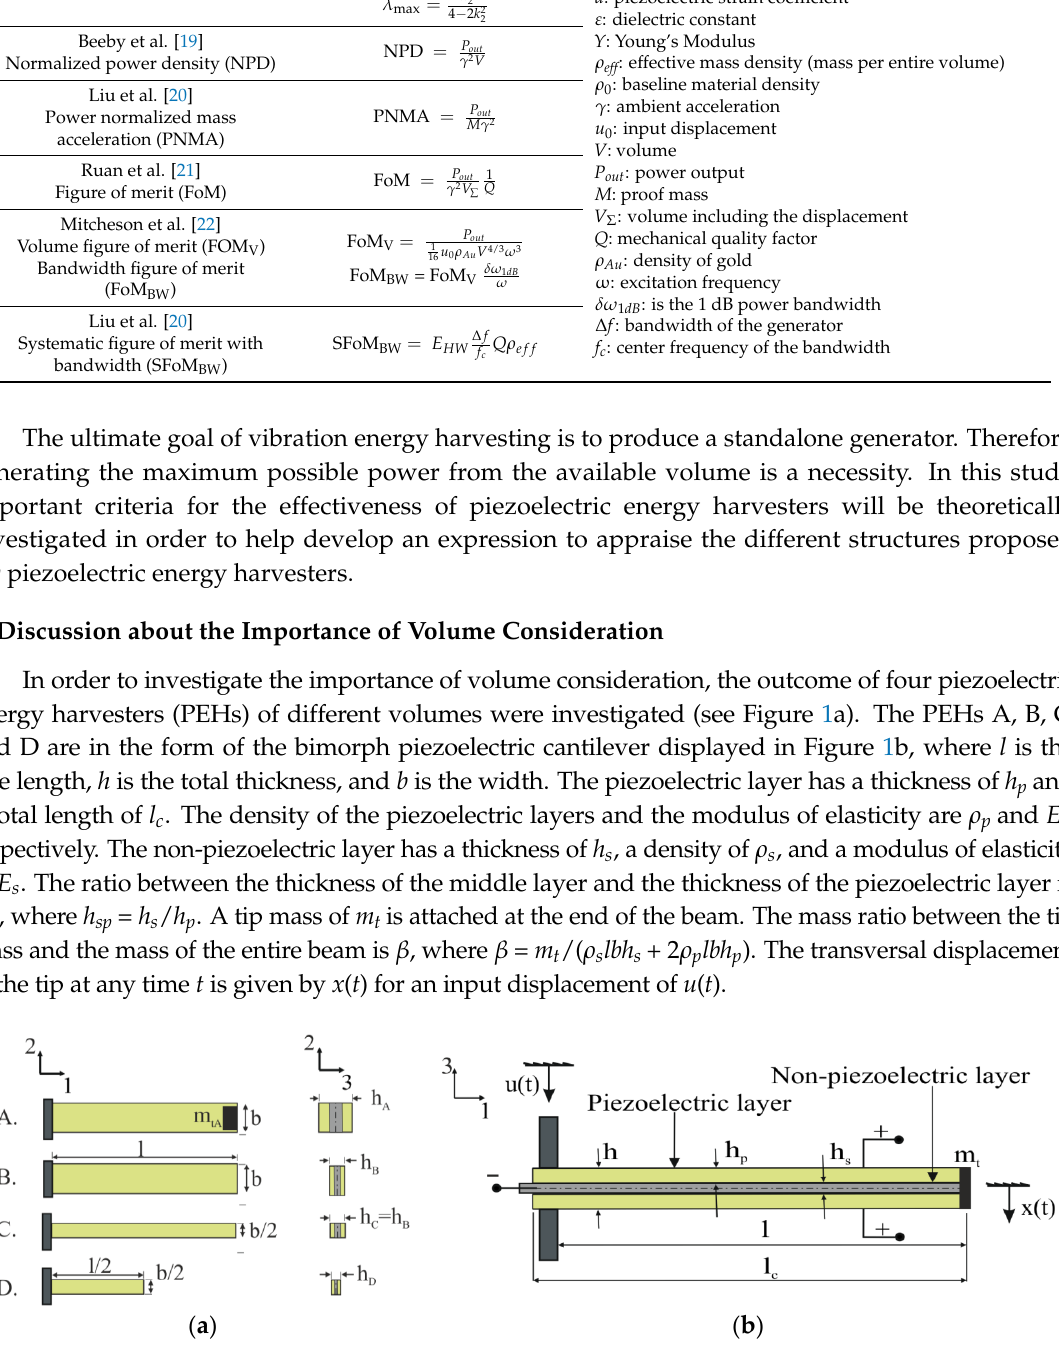
Table 3. Material properties of the bimorph piezoelectric energy harvesters.